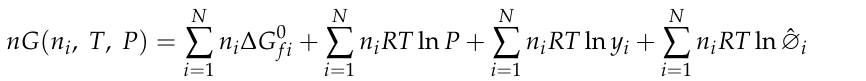
Table 1. Model compounds for the thermodynamics analysis. Symbol Model Compound Symbol Model Compound Gases Isoparaffins H 2 Hydrogen ip 6 2-Methylpentane C 1 Methane ip 7 2-Methylhexane C 2 Ethane ip 8 + 2-Methylheptane C 3 Propane Naphthenes C 4 Butane N 6 Methylcyclopentane C 5 Pentane N 7 Methylcyclohexane N 8 + Ethylcyclohexane Paraffins Aromatics np 6 n -hexane A 6 Benzene np 7 n -heptane A 7 Toluene np 8 + n -octane A 8 +